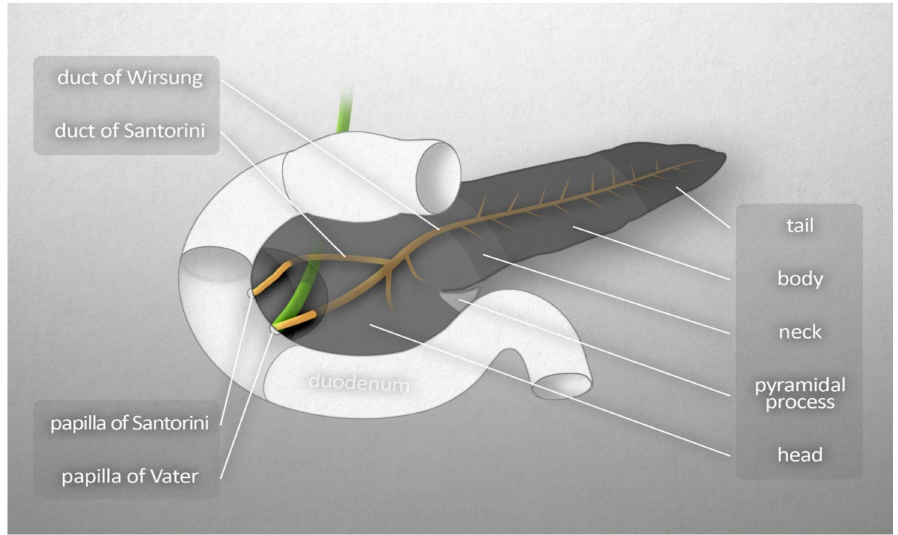
Figure 1. Macroscopic anatomy of the human